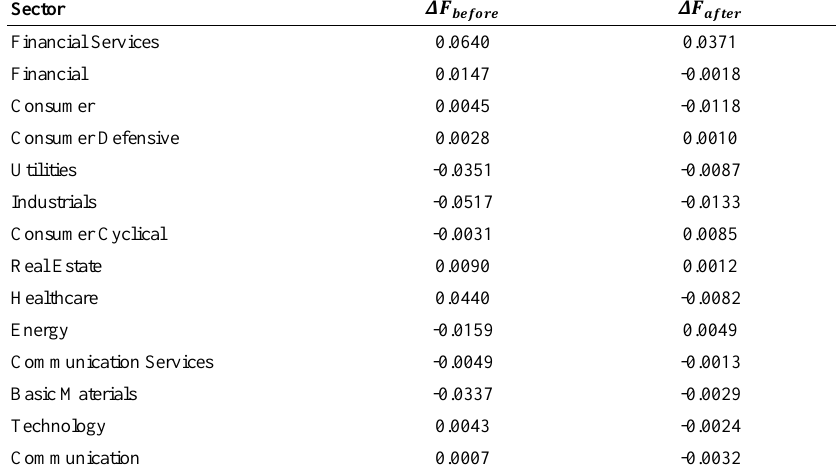
Table 3. The net information outflow for the sectors in CSI market, before and after COVID-19 outbreak